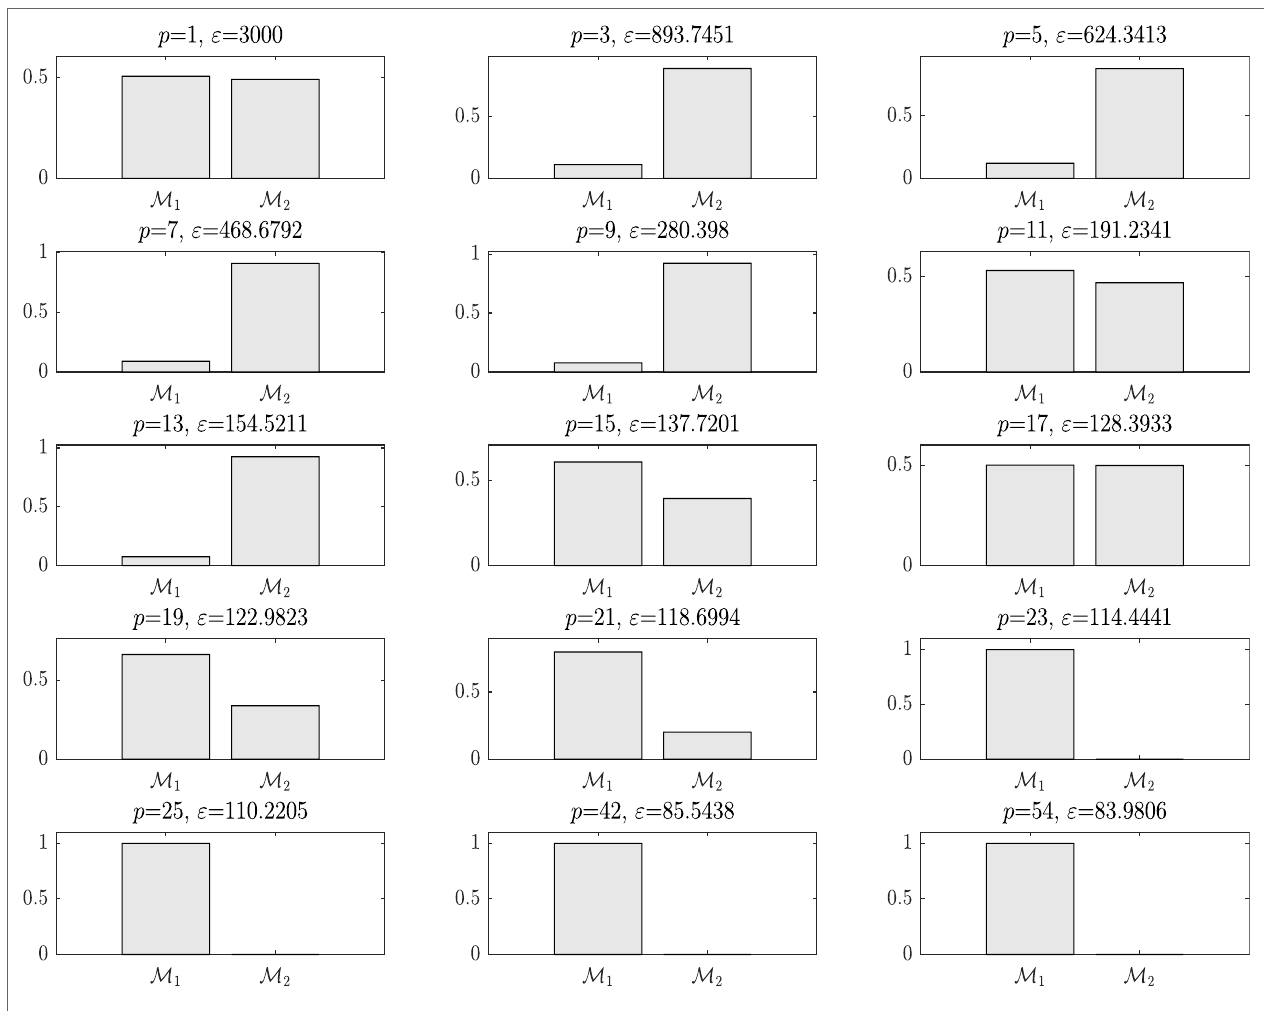
FIGURE 8 | Model posterior probabilities, example